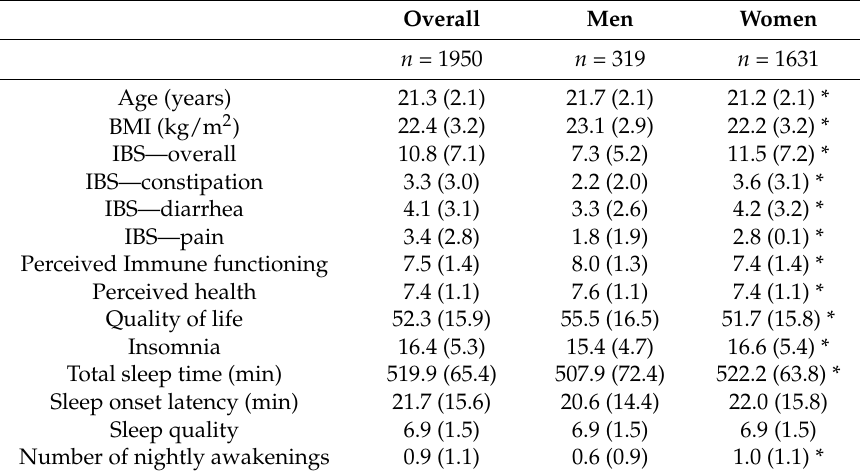
Table 1. Characteristics of the study